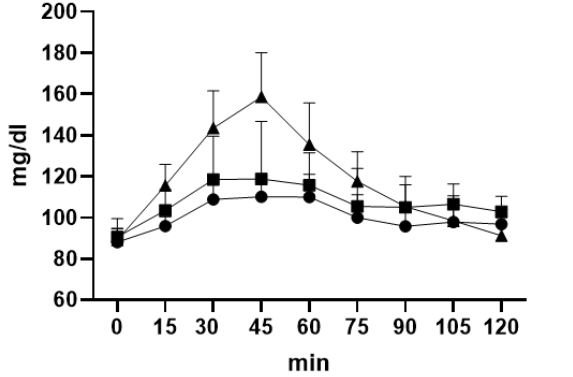
Figure 1. Biscuits glycaemic curve.